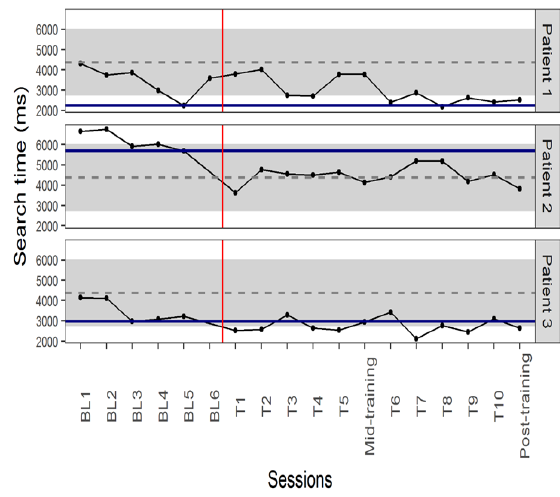
Figure 3: Manual search time (ms) changes during the baseline and training sessions, solid blue line represents the shortest baseline value for each patient. Grey dashed lines and grey backgrounds show the mean ± standard deviation search time in healthy non-gamer participants . The red vertical line separates baseline and training periods. BL= baseline, T=training day.